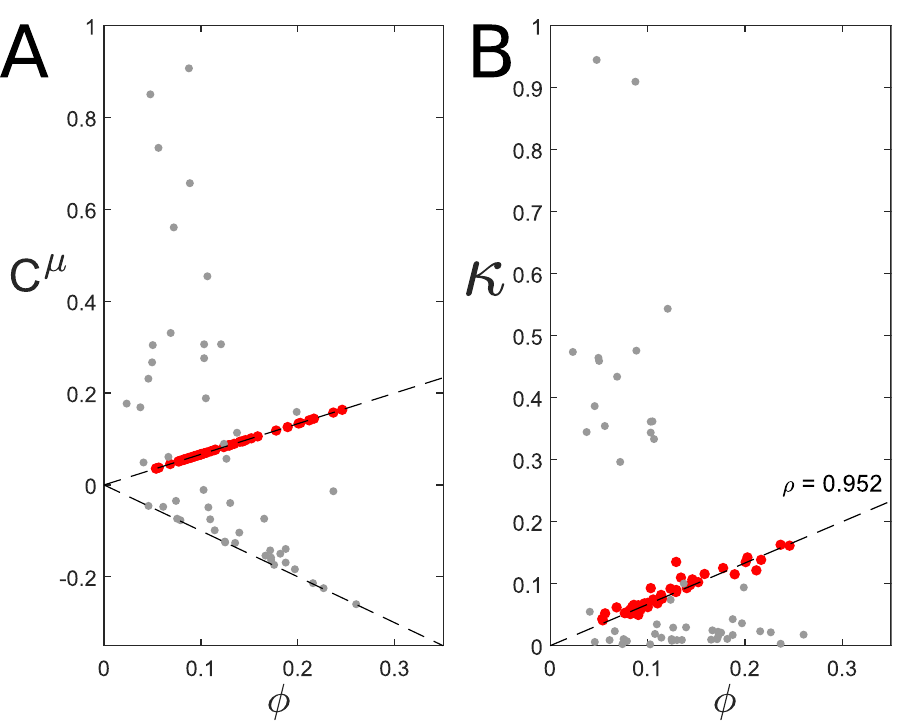
Fig 3. Perfect prediction in the case of linear noise for 10 different kinotypes. (A) Grey dots are GCCs of metabolic proteins in genotypes after 150 optimisation steps, which are not yet optimal. Red points are the GCCs in the optimal genotypes. Dashed lines are predictions for the values of GCCs for metabolic (positive) or H -proteins (negative). (B) Measured noise contributions compared to predicted noise contributions (dashed line). Red points are measured in the optimal genotype, grey points in the non-optimal